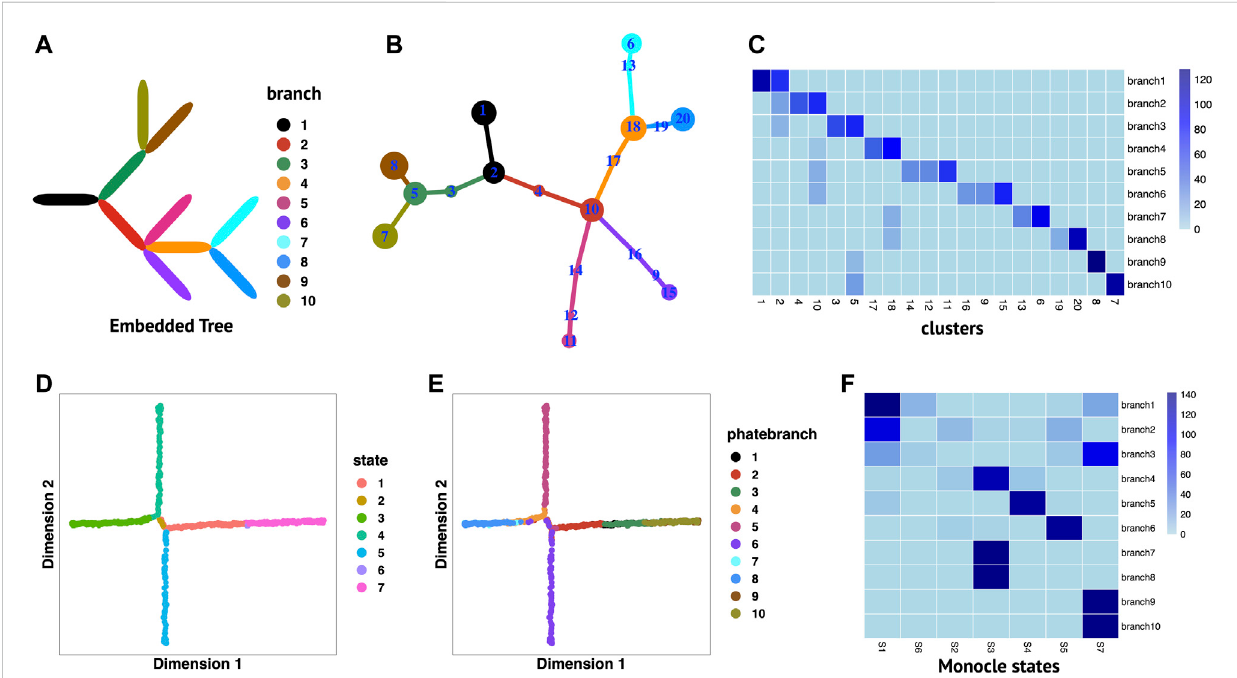
FIGURE 2 RobustTree reconstructs continuous multi-branch trajectory on PHATE data. (A) The real embedded tree structure of simulated PHATE data. (B) Tree trajectory reconstructed by RobustTree and visualized by R package igraph. The size of the cluster is proportional to the number of cells it contains, and the branch length is proportional to the distance between connected clusters. (C) Heatmap shows the percentage of cells in cluster (x-axis) distributed into real branch (y-axis). (D) Monocle2 reduces dimension on PHATE data. (E) Truth branch assignment on 2D embedding of Monocle2. (F) Heatmap shows the percentage of cells in Monocle states (x-axis) distributed into real branch